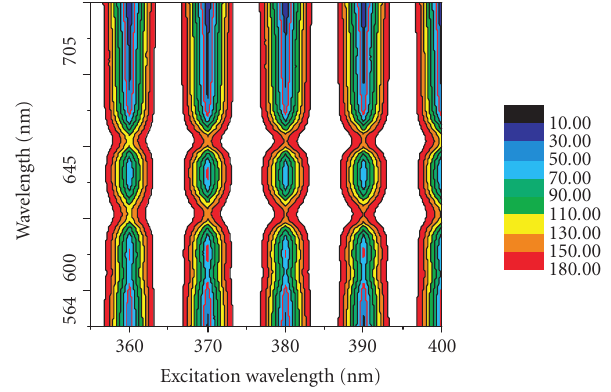
Figure 11: Contour view of the emission spectra of Sm 3+ ion in MC-Sm complex at di ff erent excitation wavelengths in DMSO.